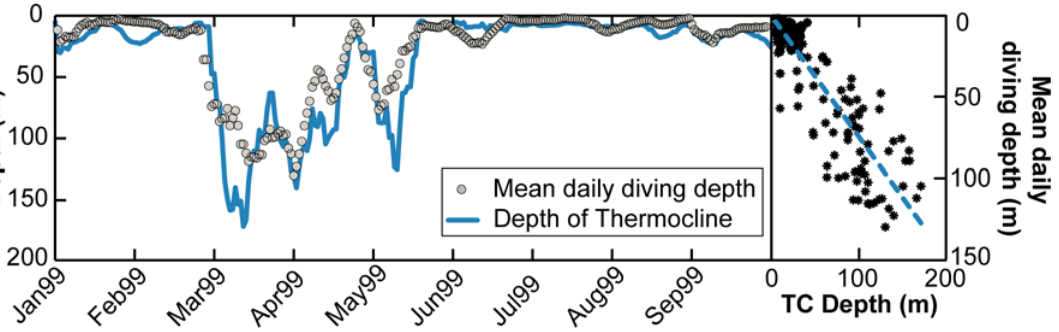
Figure 11. Example of relationship between mean daily diving depth (grey circles) and corresponding mean daily depth of estimated thermocline (blue line) for one fish (WC98-508; LSFR, R 2 =0.92; P ,